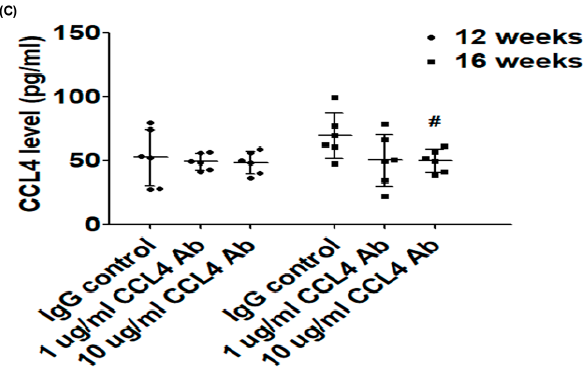
Figure 1. The effects of C-C chemokine motif ligand (CCL4) antibody treatment on cytokines. Serum levels of interleukin (IL)-6 ( A ), tumor necrosis factor (TNF)- α ( B ), and CCL4 ( C ) ( n = 6 in each group). # p < 0.05 compared with the IgG 2A isotype control group.